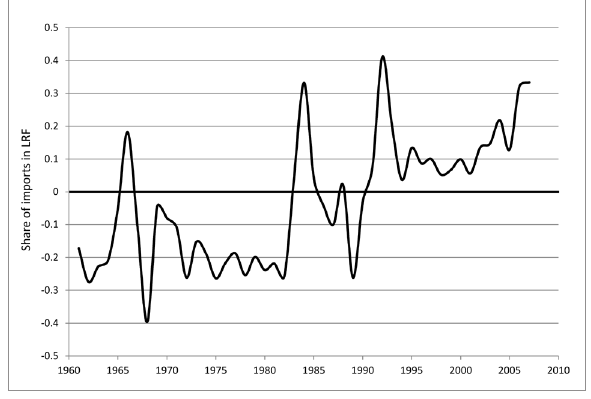
Share of the total national land requirements for food (LRF) met by net imports in South Africa from 1961 to 2007. The variation in import shares is significantly associated with the fluctuation in total LRF. Imports accounted for a significantly higher proportion at peak points in some years more than in others. These peak years possibly correspond with the years of low production during droughts or social unrest, for example. 44 For instance, because of a regional drought in the early 1990s, maize production dropped to just over 3 million tons in 1992. Therefore, approximately 5 million tons of maize was imported during that year. The trend of import share is negatively correlated with South Africa’s self-sufficiency (-0.72), indicating that the nation increasingly depended on imports to meet LRF and that increases in total LRF in recent decades were mainly met by land outside South Africa’s